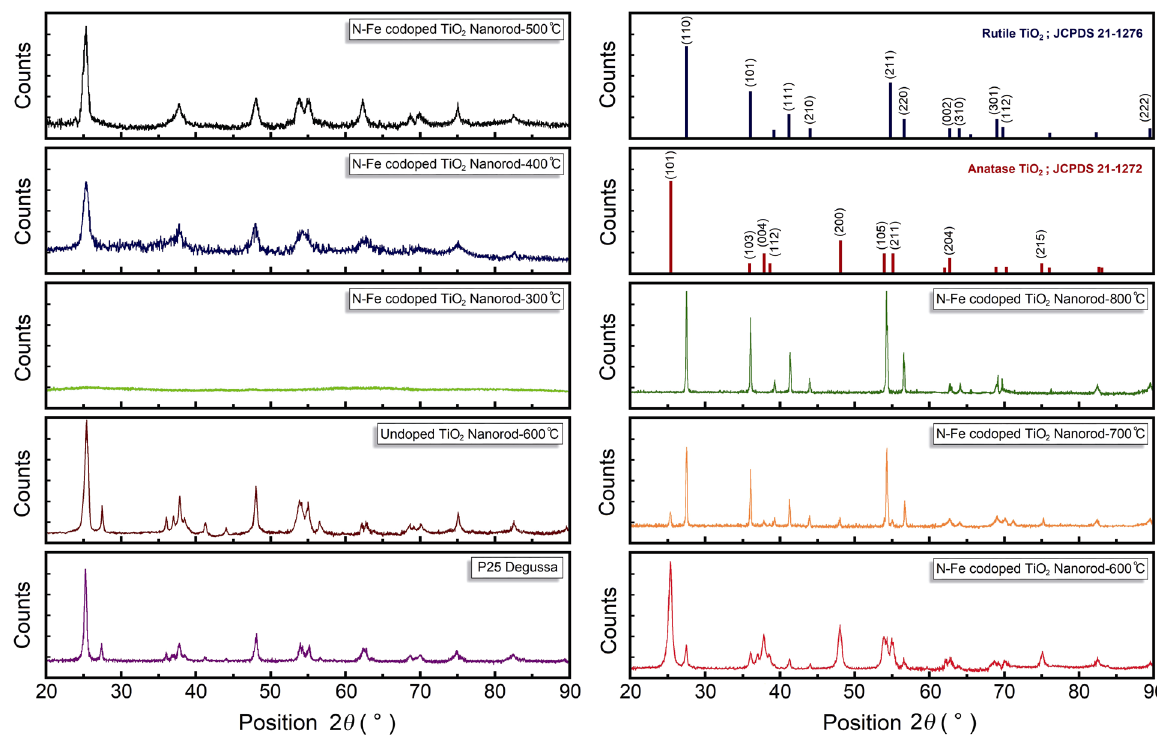
Fig. 3 Typical XRD patterns of P25 nanoparticles, undoped TiO 2 nanorod, and N–Fe codoped TiO 2 nanorods annealed at different temperatures from 300 to 800 ℃